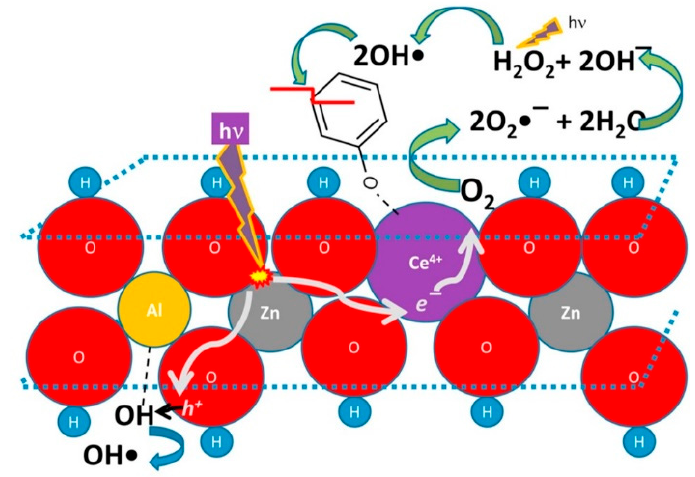
Figure 7. Proposed photocatalytic mechanism for the cerium presence in ZnAl LDH materials and its role as charge separator. Adapted from Reference [131]. Copyright 2016 Elsevier.